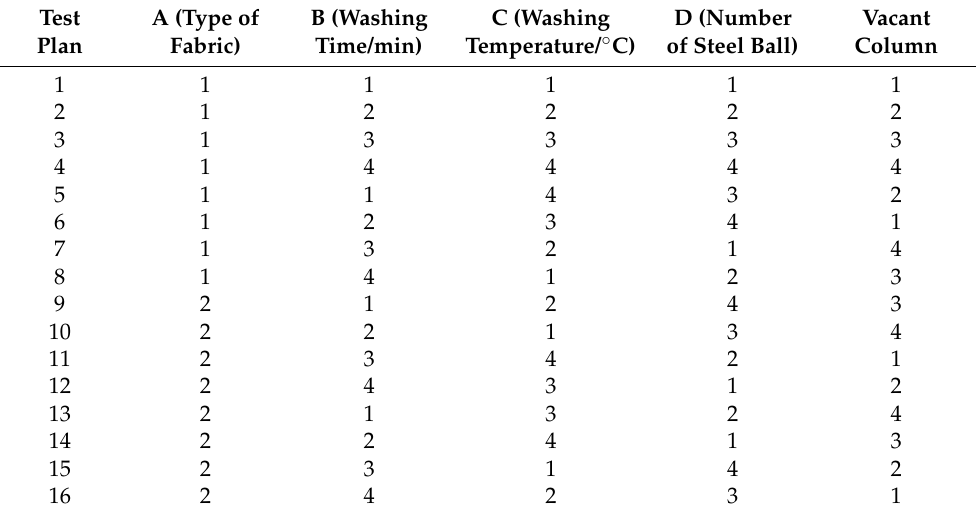
Table 4. The vacant columns in the table are used to indicate error factors. Table 4. Orthogonal experimental